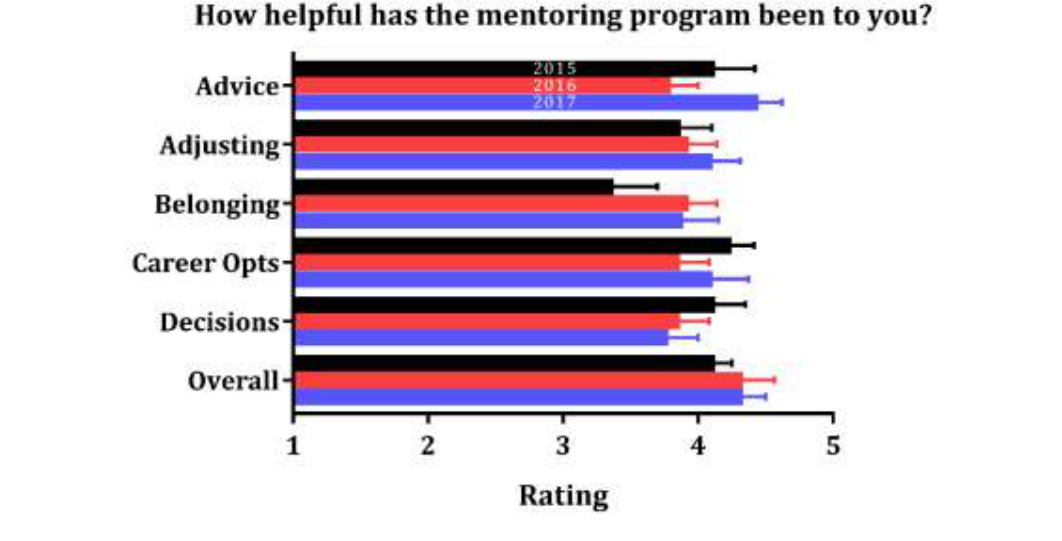
Figure 1. Mentee’s mean ± SEM ratings of the program’s helpfulness (2015-2017), on a scale of 1. Very unhelpful, 2. Unhelpful, 3. Neutral, 4. Helpful, and 5. Very